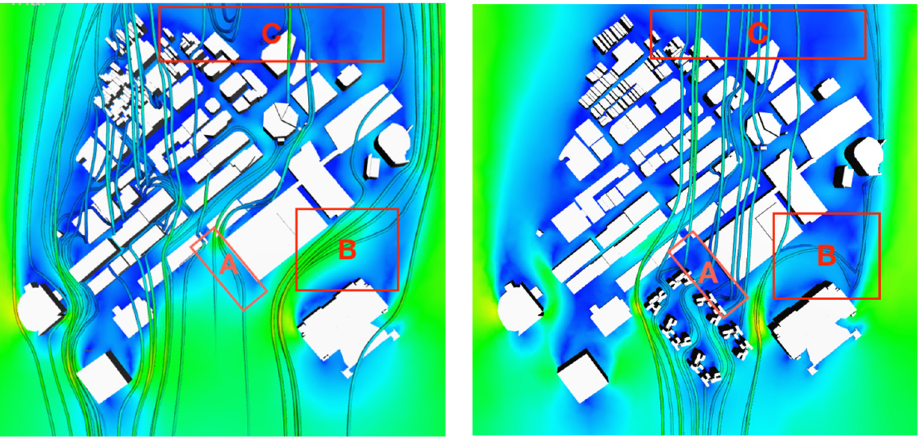
Figure 19. Comparison of wind velocity contour plots at the pedestrian level ( left —without modular buildings, right —with modular buildings).